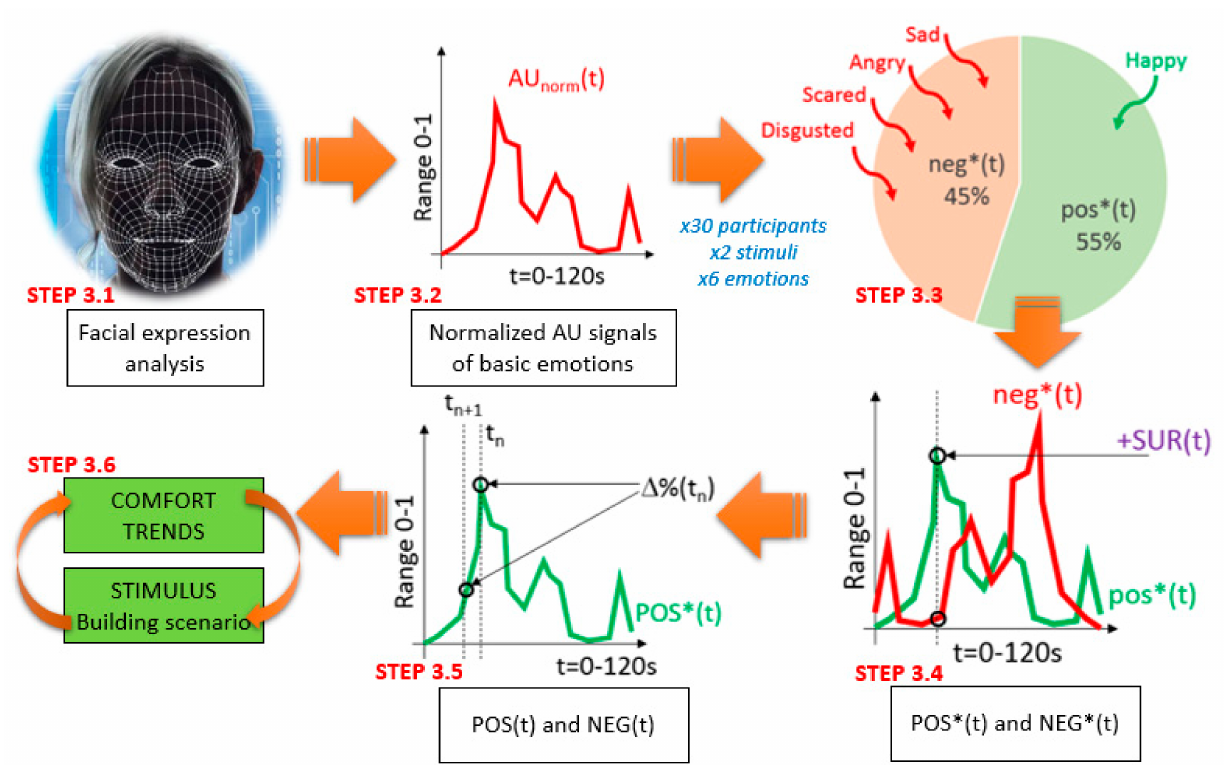
Figure 9. Schematic procedure for the post-processing analysis of AU of basic emotions (STEP 3) and detection of comfort